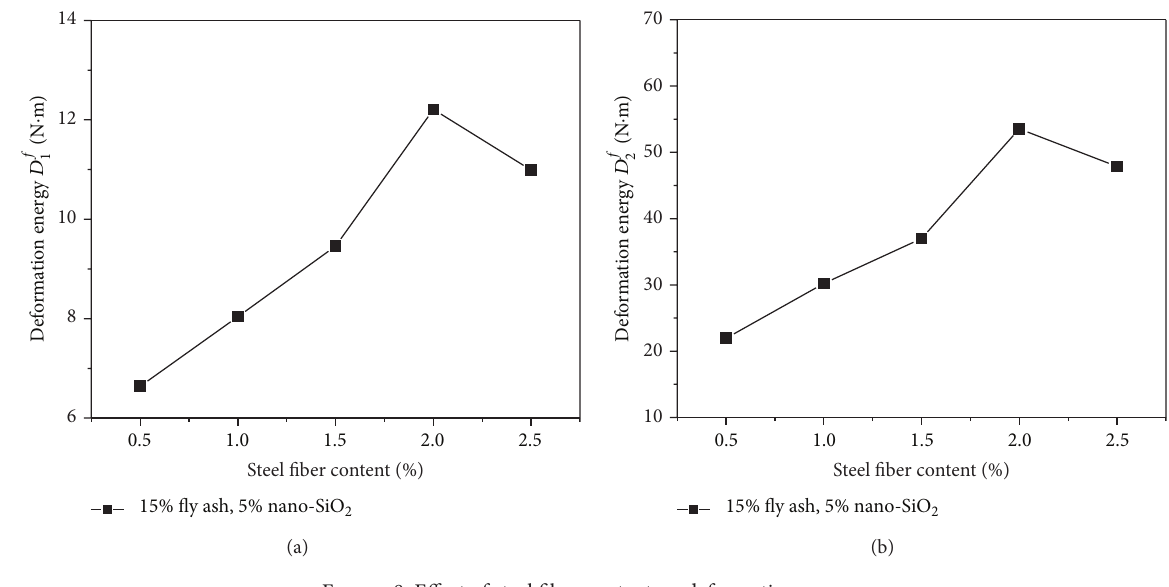
Figure 8: Effect of steel fiber content on deformation